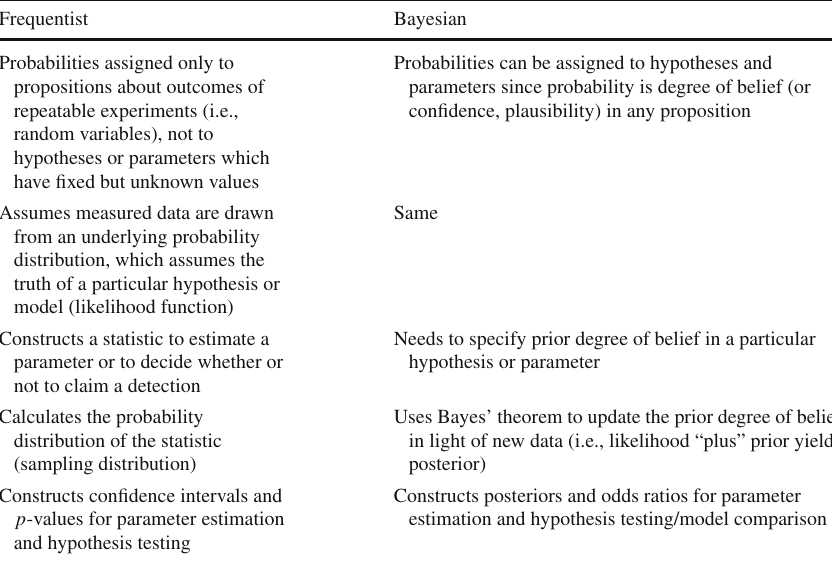
Table 2 Comparison of frequentist and Bayesian approaches to statistical inference Frequentist Bayesian Probabilities assigned only to propositions about outcomes of repeatable experiments (i.e., random variables), not